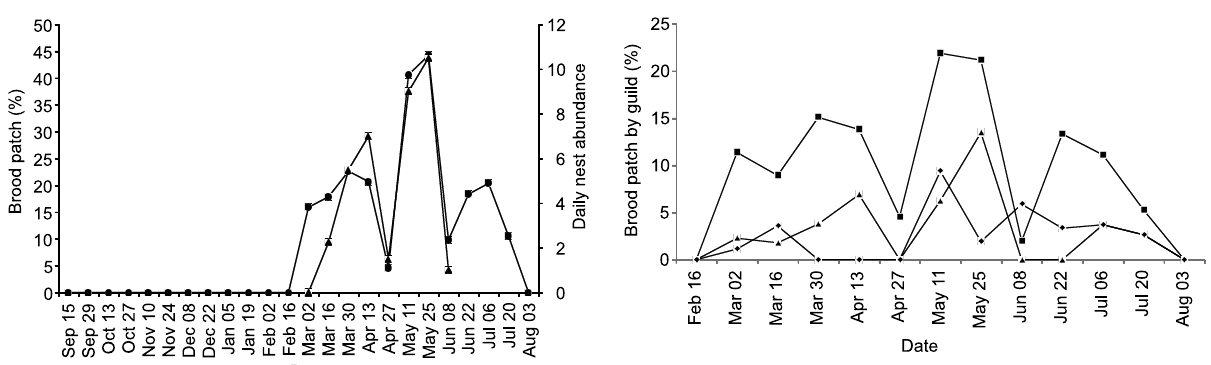
Figure 3. Occurrence of brood patches in purely-insectivorous ( ■ ), insectivorous-frugivorous ( ▲ ) and insectivorous-granivorous (  ) species. Percentage of individuals with brood patches calculated per netting session based on number of